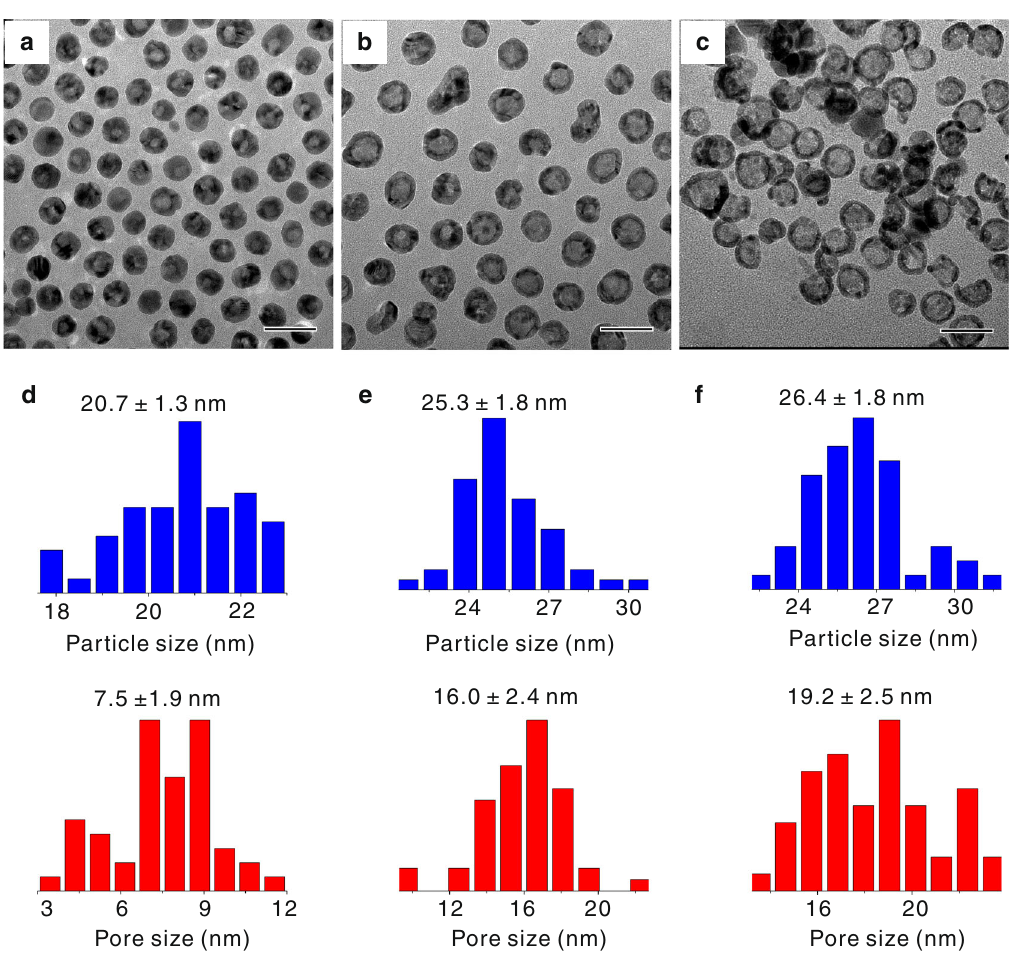
Fig. 5 Size variation of the hollow nanocrystals obtained after repeated Kirkendall cavitation processes. TEM images and statistical analyses of particle size and pore size distribution for a , d H-Pd-1, b , e H-Pd-2, and c , f H-Pd-3. Scale bars in a – c are 50